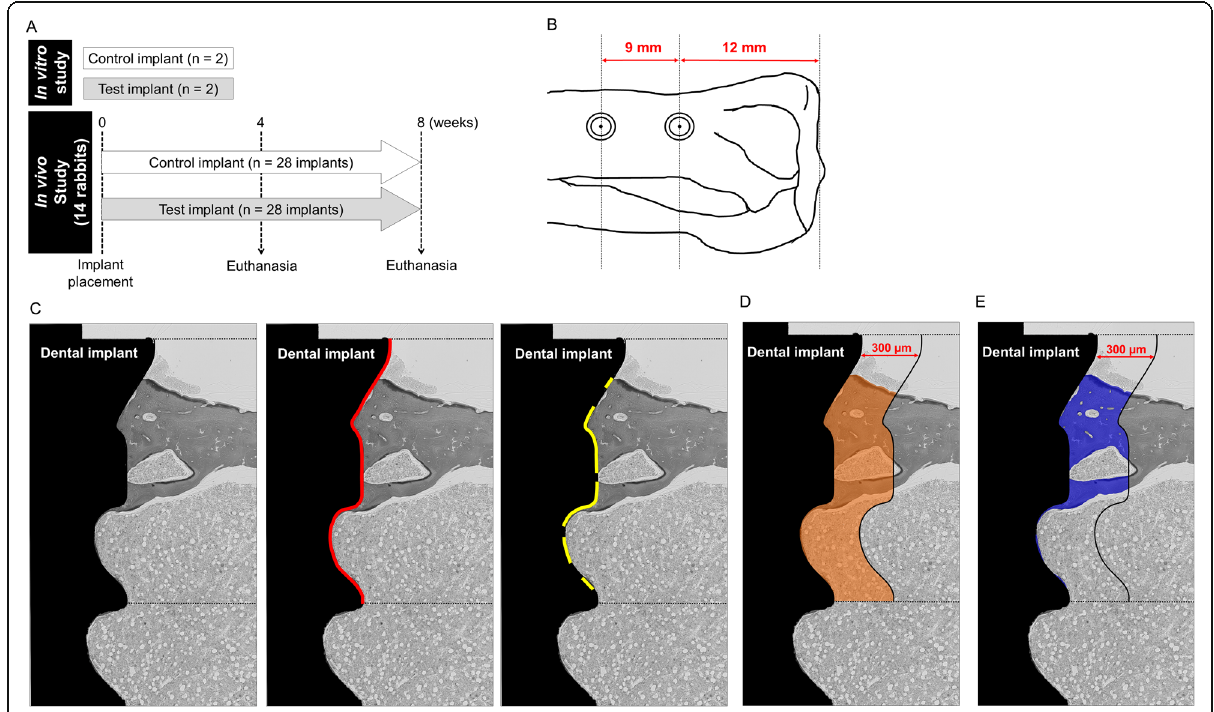
Fig. 1 a Experimental schedule. b Placement positions of proximal and distal implants in rabbit tibiae. c Evaluation of bone-to-implant contact. Red and yellow lines indicate the analyzed length of implants and bone in contact with the implant surface, respectively. d , e Areas of interest (AOIs) for histomorphometric analyses. Orange- and blue-surrounded areas indicate total tissue and bone area, respectively. AOIs are defined as areas surrounding the implant neck to the lower border of the second thread and 0 – 300 μ m away from the implant